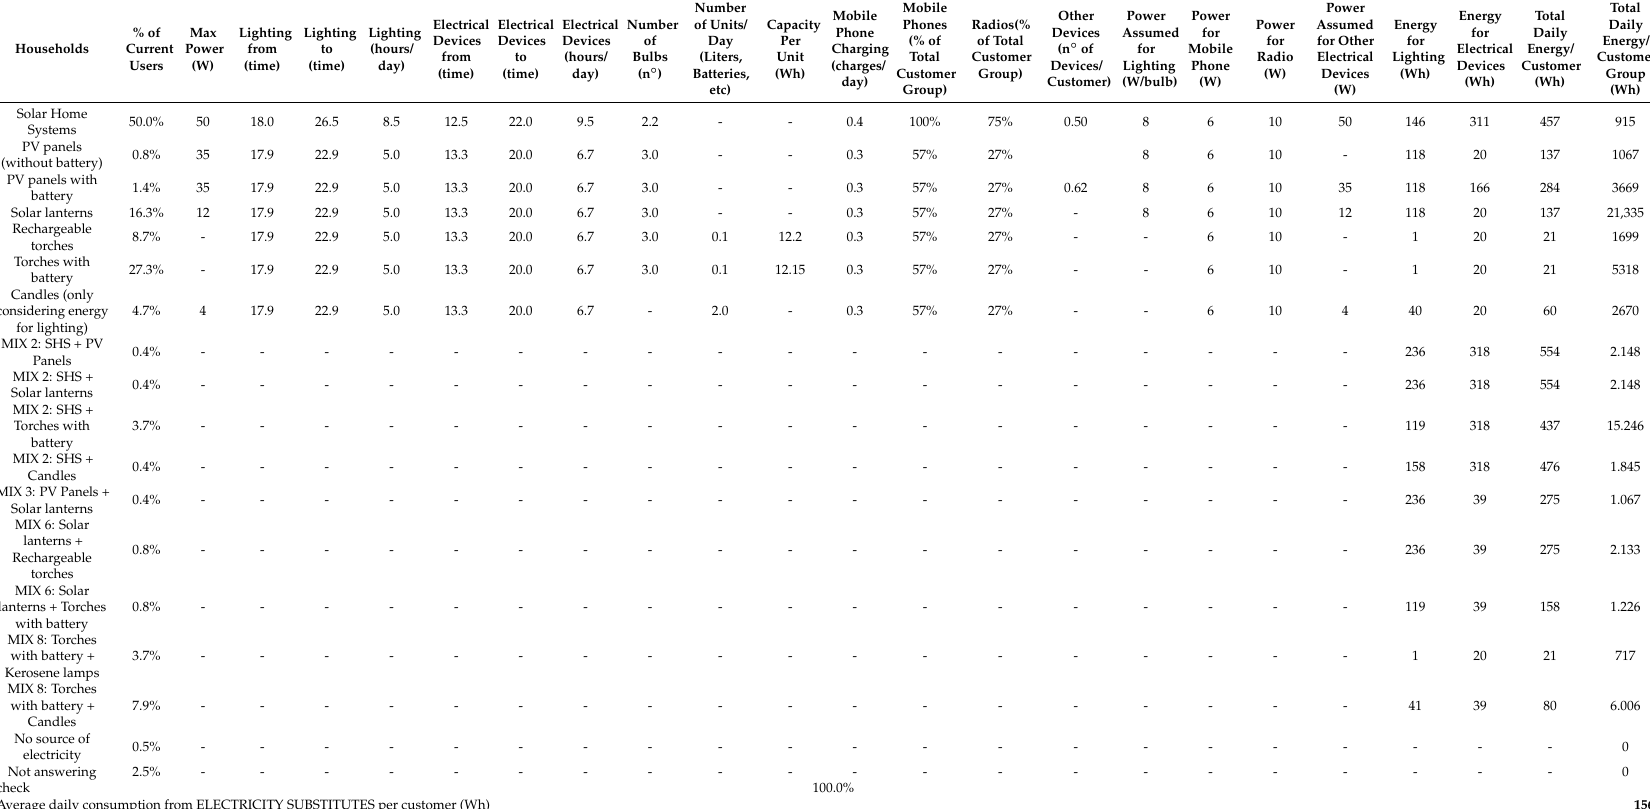
Table 6. Calculation of the average daily consumption from electricity substitutes per customer.